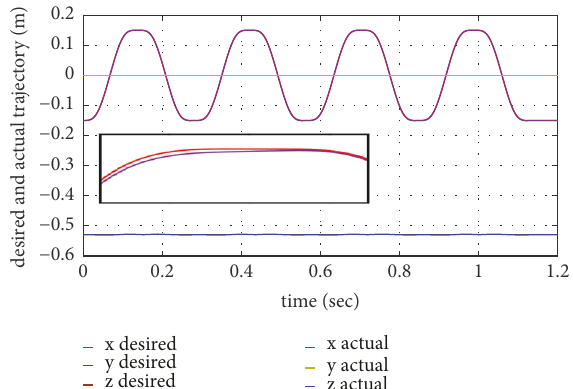
Figure 8: The traces of the desired trajectory.